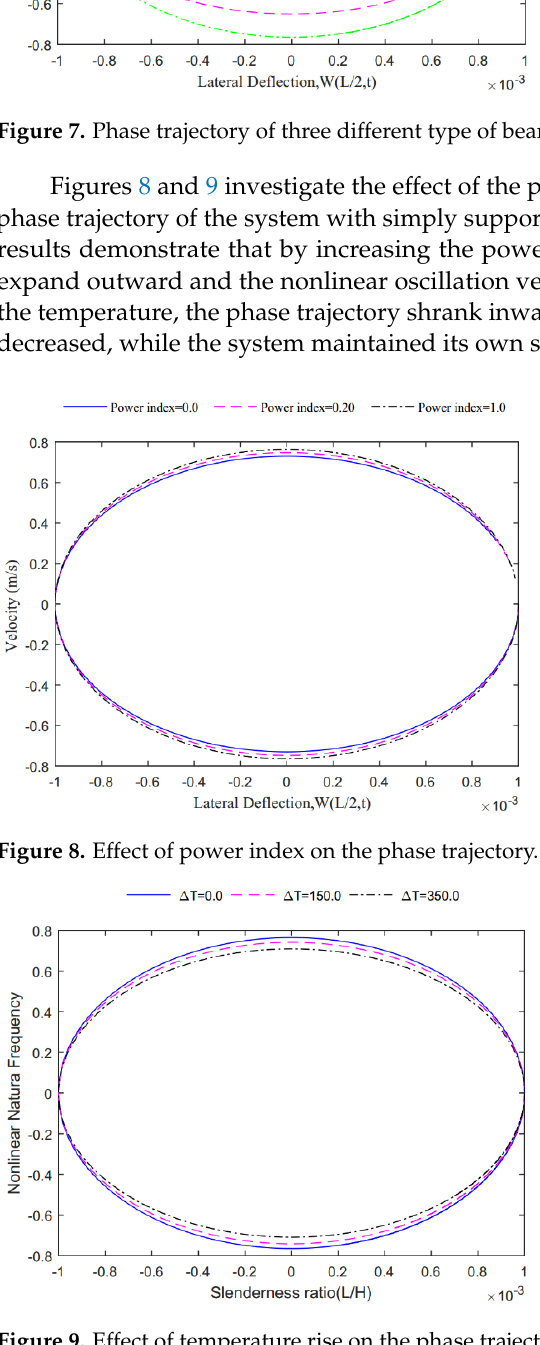
Figure 9. E ff ect of temperature rise on the phase trajectory. Figure 9. Effect of temperature rise on the phase